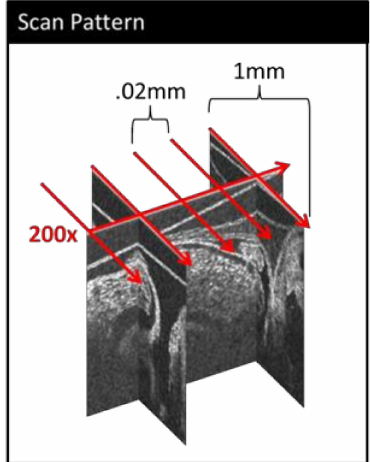
Figure 1. A simplified schematic of our custom 4-D optical coherence tomography (OCT) scan pattern. 200 b-modes (frames) are collected along the approximate centerline of the outflow tract (OFT) (longitudinal scan). Then, a series of 200-frame b-mode sequences are collected perpendicular to the initial scan (cross-sectional scans) at evenly spaced distances along the